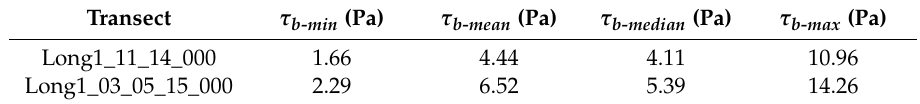
Table 5. Bed shear stress τ b . Legend: τ b-min = minimum bed shear stress; τ b-mean = mean of the bed shear stress; τ b-median = median of the bed shear stress; τ b-max = maximum bed shear stress.